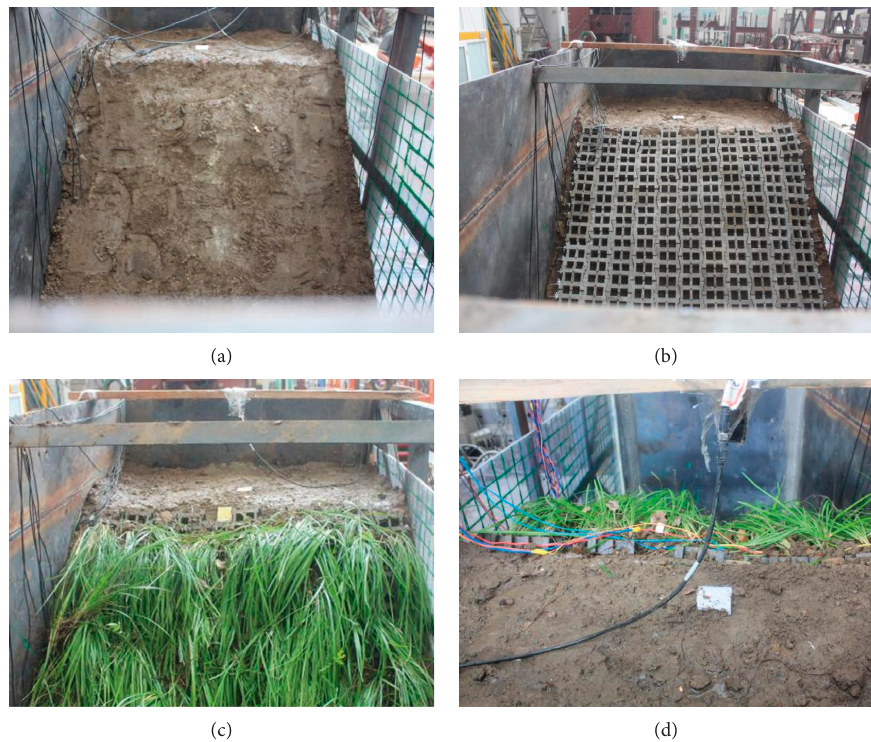
Figure 3: Test models. (a) Natural slope without vegetation. (b) Hinged block slope. (c) Hinge block slope with ecological protection. (d) Anchor + hinged block ecological slope.